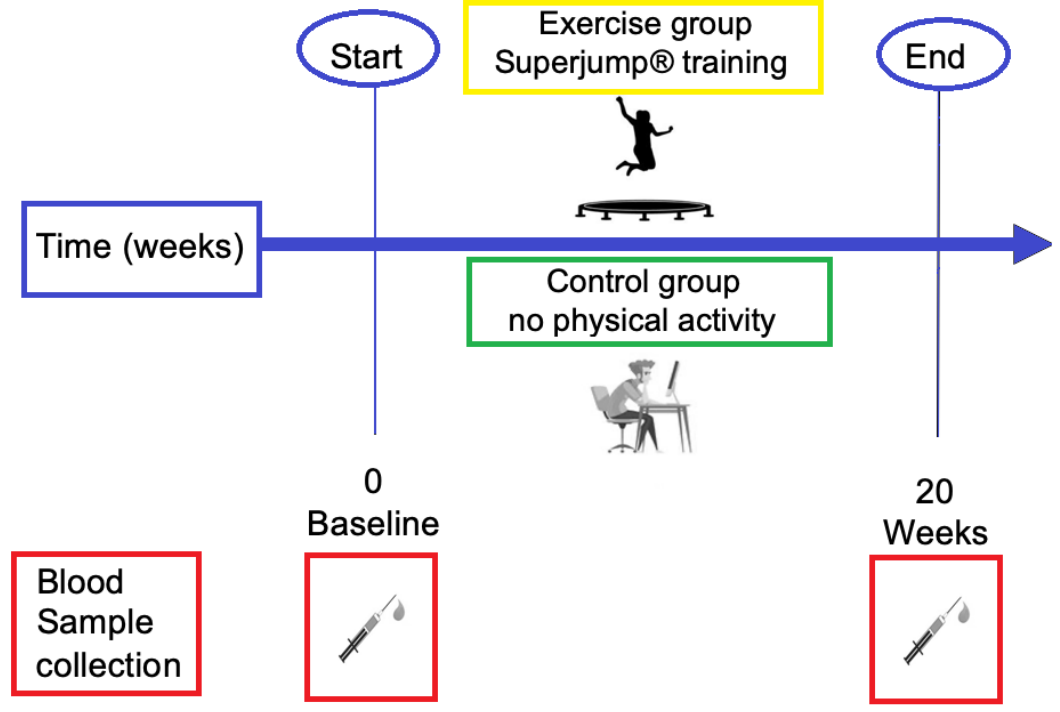
Figure 1. Overview of the experimental design. Blood samples were collected at baseline, at time 0, and after twenty weeks in the two groups of study (control group and exercise group). In the exercise group, SuperJump activity was performed for a total of 20-weeks, three times a week, 60 min each session. The control group did not perform physical activity.